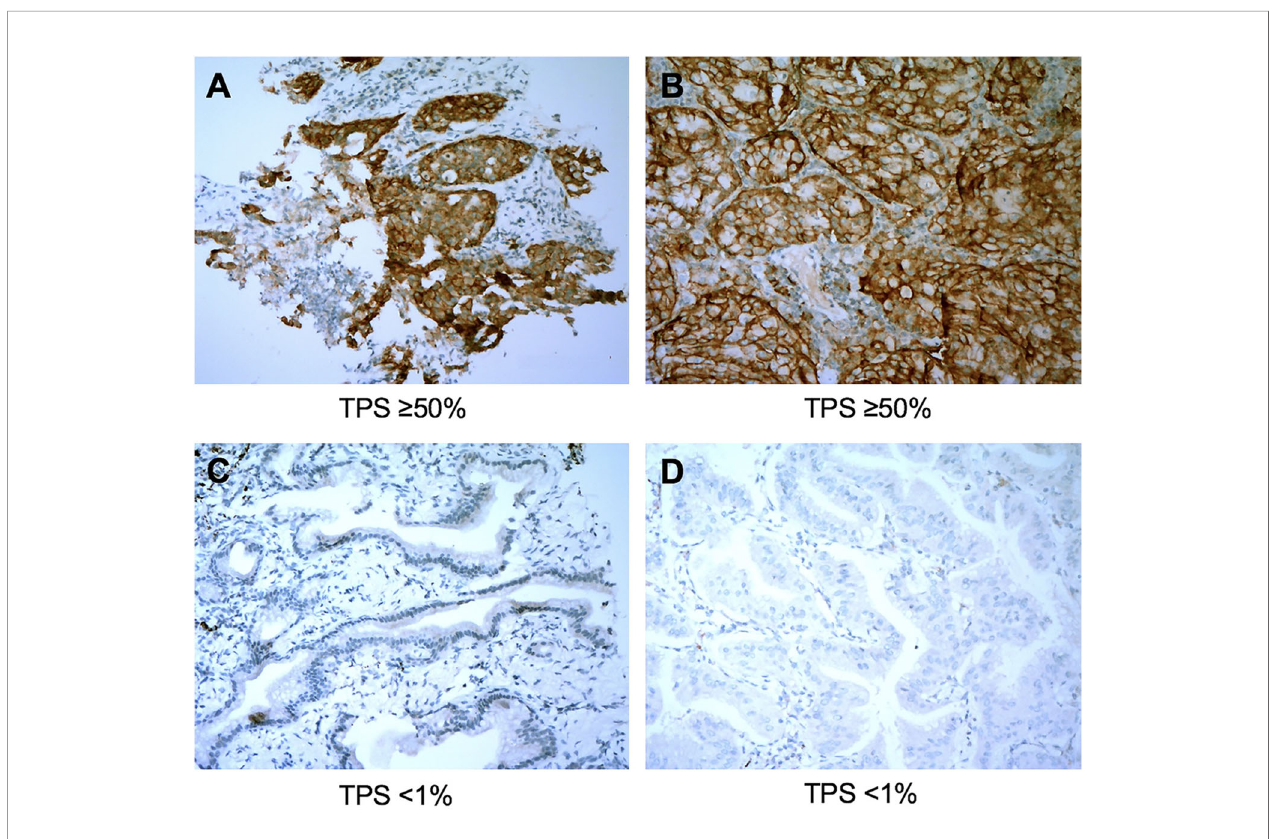
FIGURE 2 | Representative images of concordant cases between biopsy specimens (left panel) and matched surgical resection specimens (right panel). The PD-L1 Tumor Proportion Score (TPS) in the biopsy tumor specimen (A) and the corresponding resected tumor (B) were both ≥ 50%. PD-L1 TPS in the biopsy tumor (C) and the matched resected specimen (D) were both <1%. All images are at ×40 magni fi